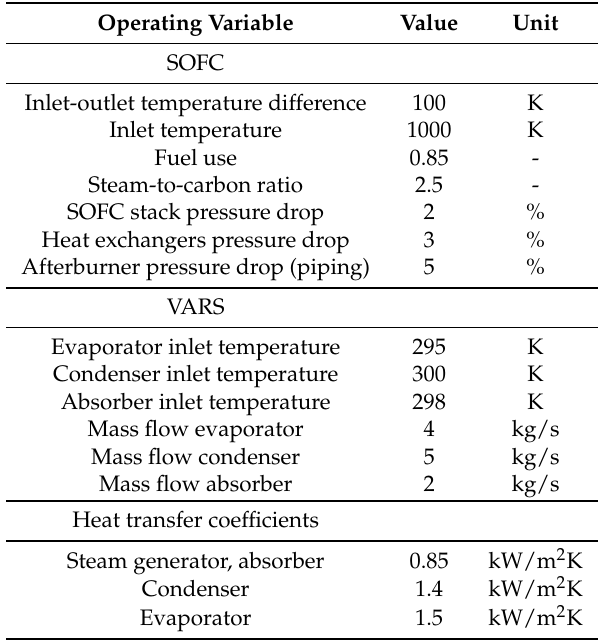
Table 3. Reference control parameters for the SOFC-VAR